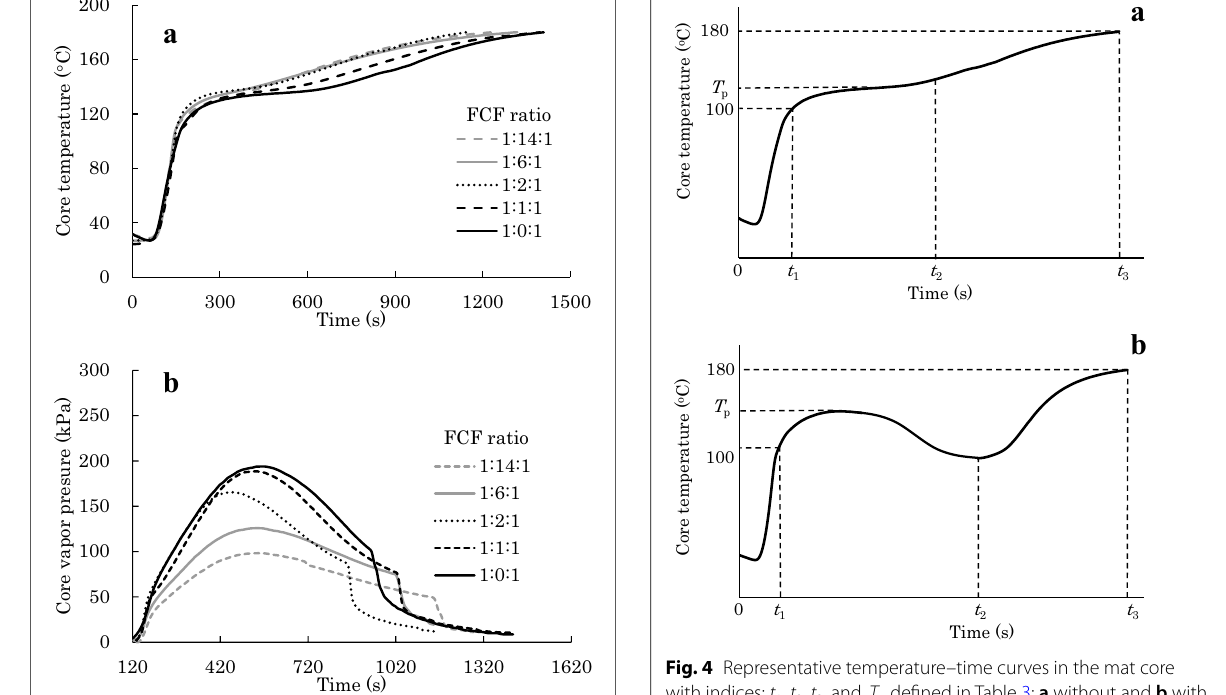
t s is the time at which the vapor pressure begins where increasing.